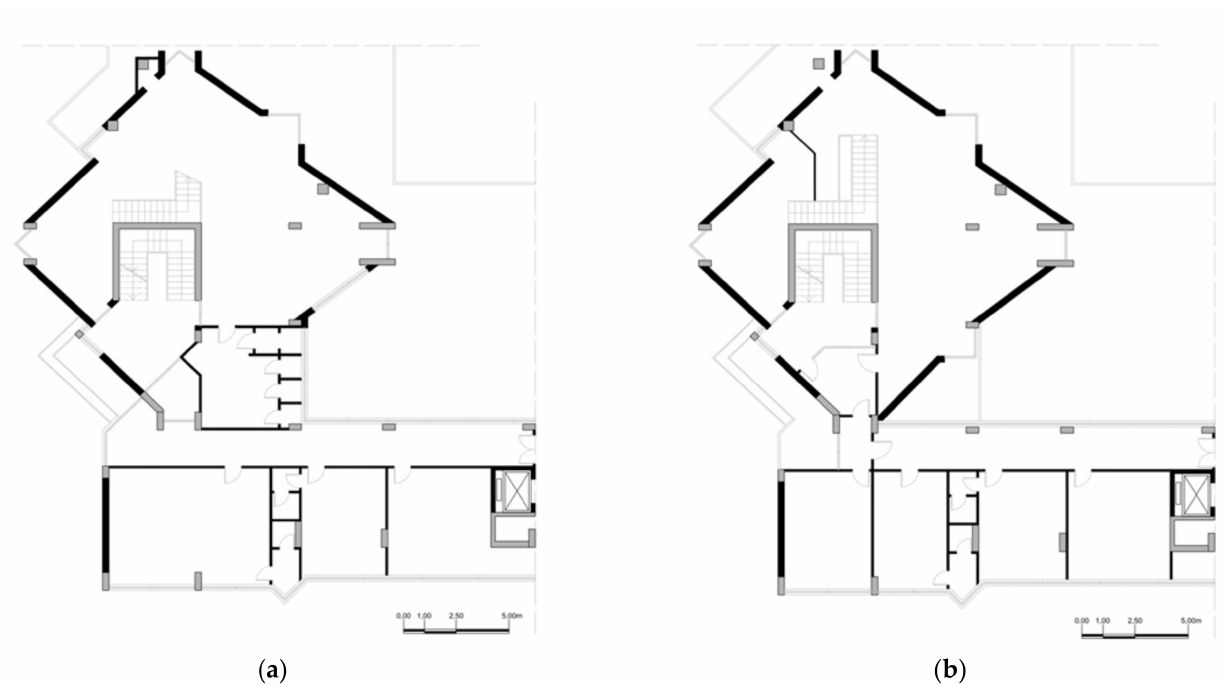
Figure 4. Building Plans: ( a ) First floor; ( b ) Second floor.